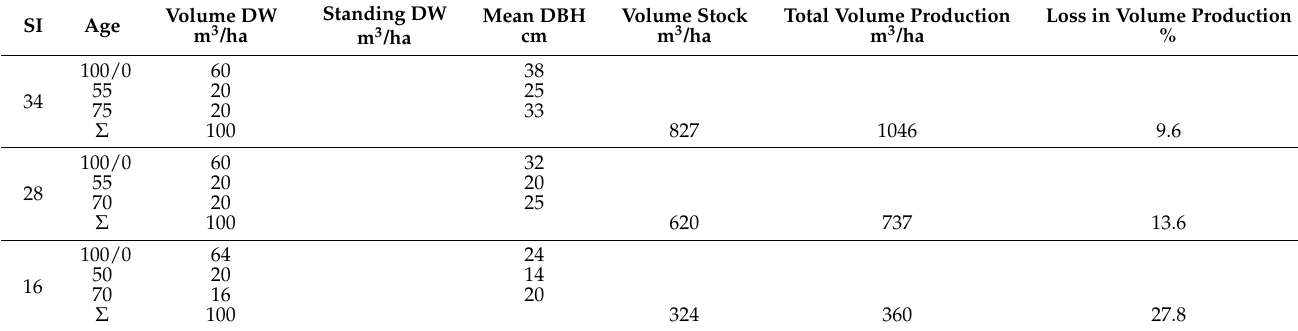
Table 3. Design of active deadwood (DW) management for Norway spruce/silver fir.